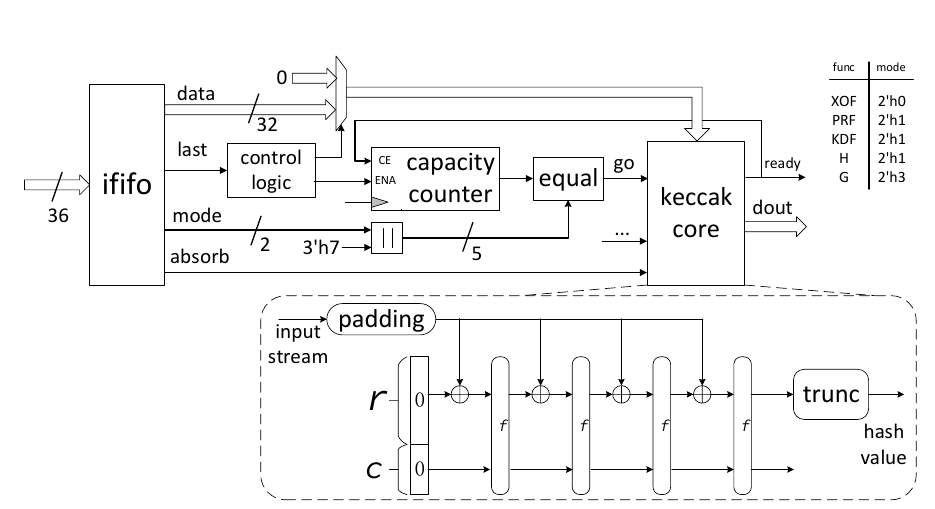
Figure 7: Detailed structure of hash module and sponge structure within Keccak core